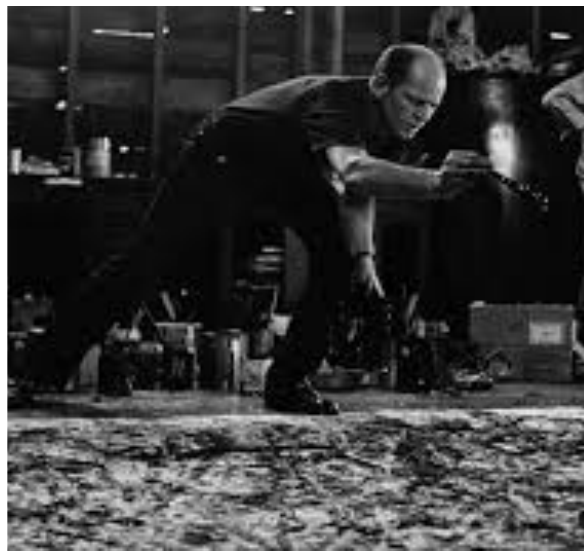
Figure 9 | Pollock in action, painting from a